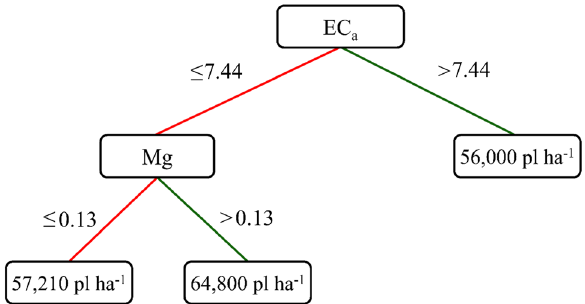
Figure 7. Decision tree generated using apparent electrical conductivity (EC a ) and magnesium (Mg) as the variables selected by the trial analysis. The software used to create this figure was Genes (v1999.2019.44, http:// arqui vo. ufv. br/ dbg/ genes/ gdown1.